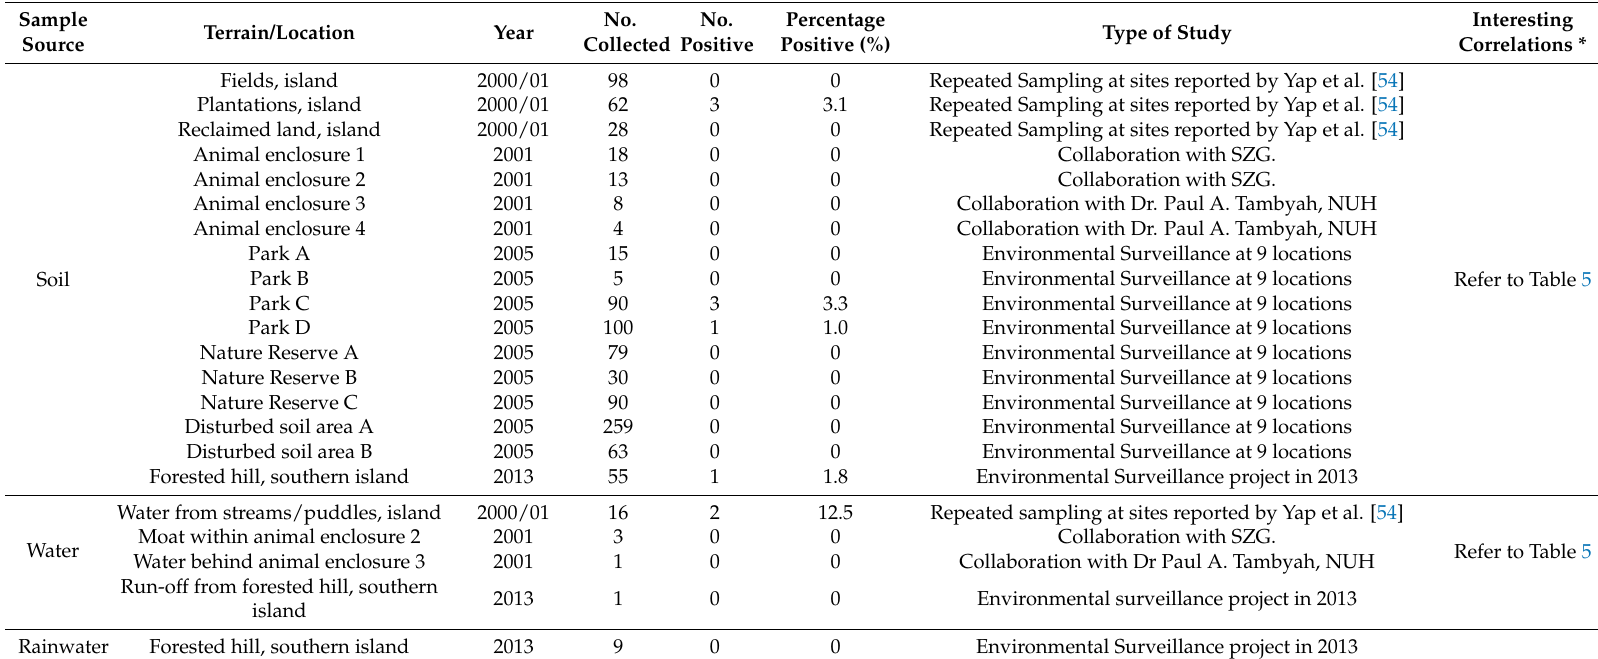
Table 4. Environmental surveillance of B. pseudomallei in Singapore between 2000 and 2013